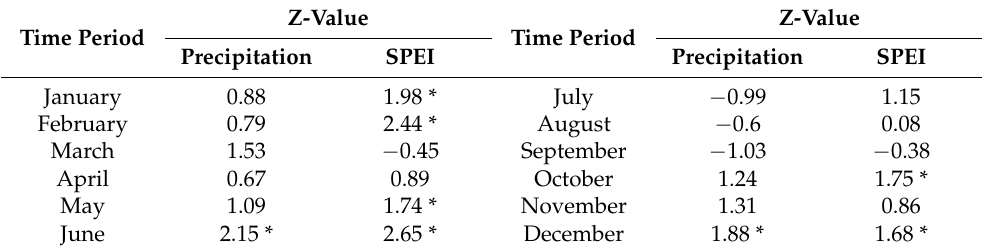
Figure 3. Seasonal precipitation and SPEI series within the SHRB from 1960 to 2019. ( a – d ) show the precipitation series within the SHRB in spring, summer, autumn, and winter, respectively. ( e – h ) show the SPEI series within the SHRB in spring, summer, autumn, and winter, respectively. Table 2. Statistics of the Z ‐ value of the MMK test for precipitation and SPEI on yearly and seasonal Table 3. Z-values of the MMK test for precipitation and SPEI on a monthly scales.